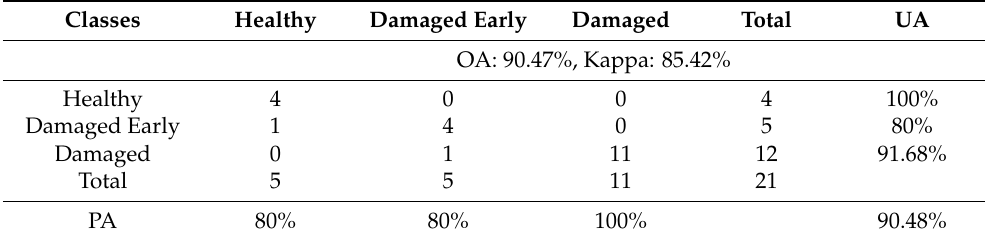
Table 3. Confusion matrix and evaluation index based on optimal mother wavelet basis (coif3) model of chlorophyll content.